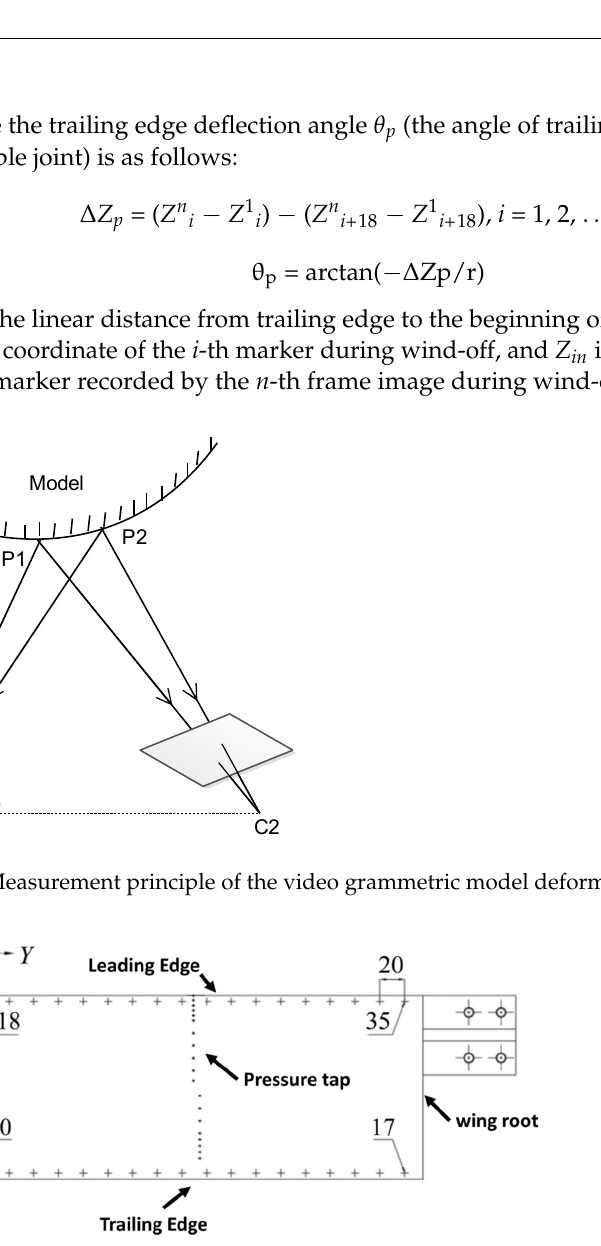
Figure 13. Markers on the model